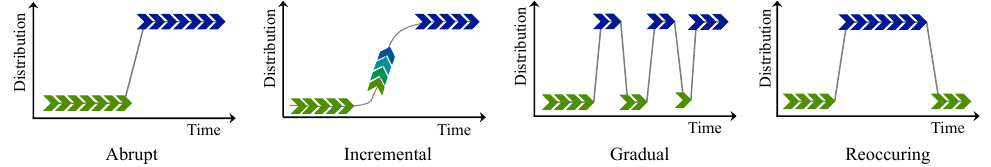
Figure 9. Different types of concept drifts that display possible data distribution changes over time (based on